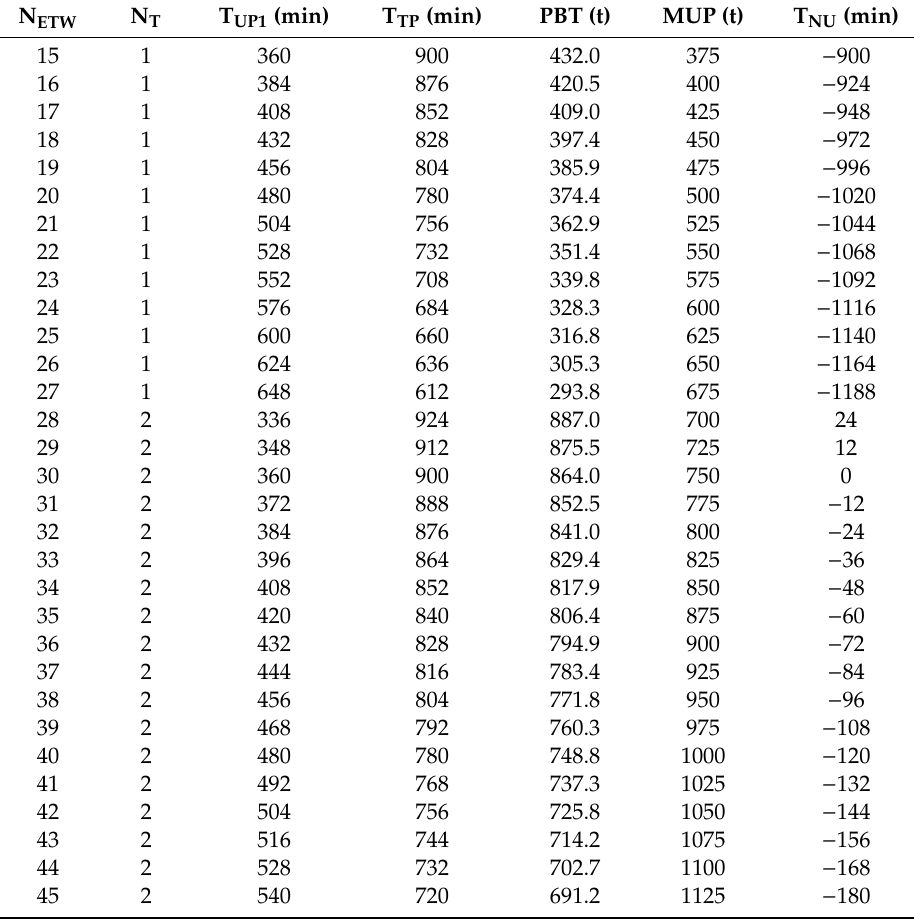
Table 5. Results for E = 0.84 and Q = 854 t.